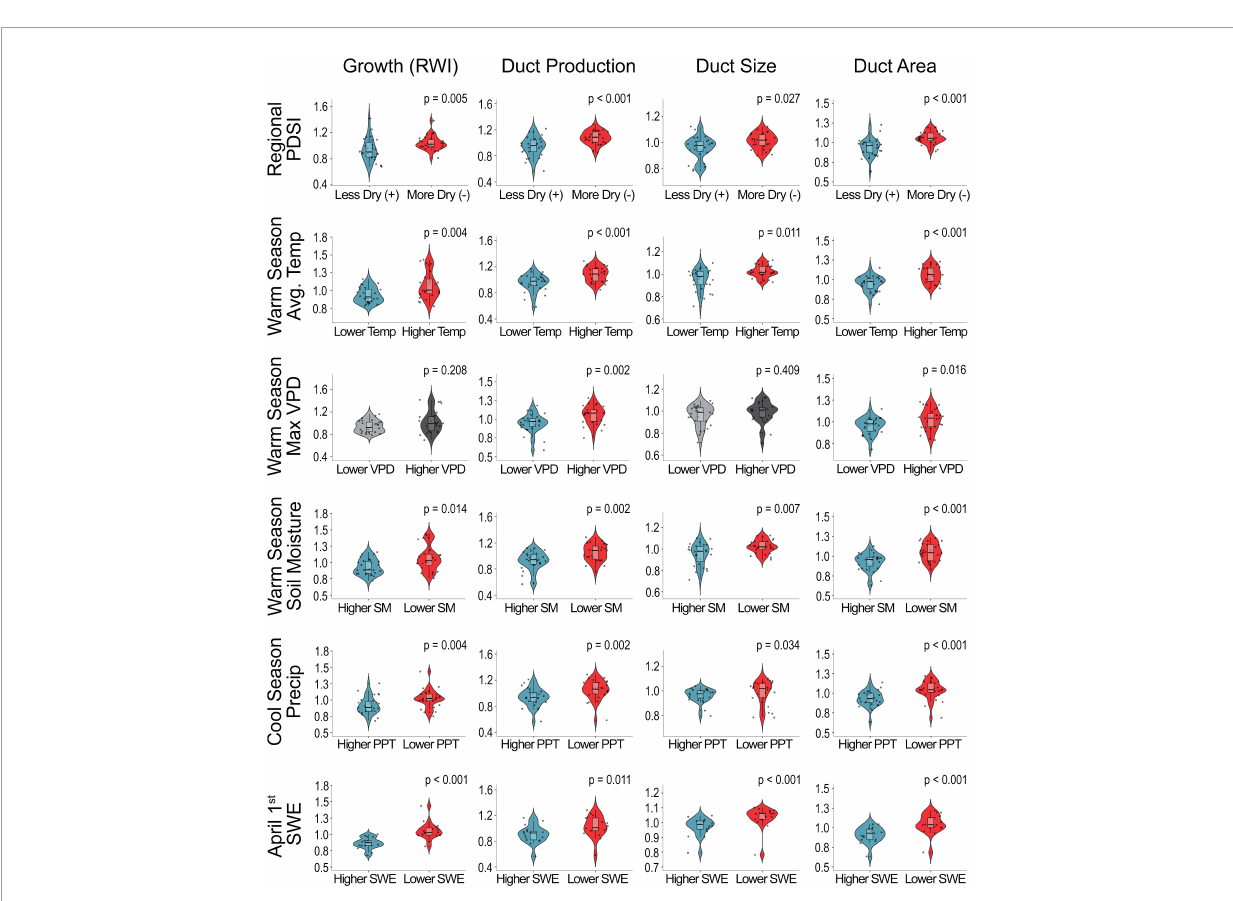
FIGURE3 Comparison of detrended whitebark pine tree growth and resin duct morphology across the upper and lower quartiles of reported climate variables from 1924 to 2015: annual average palmer drought severity index (PDSI), warm season (May-September) average temperature ( ◦ C), maximum vapor pressure deficit (VPD), soil moisture storage, cool season (October–April) precipitation (mm), and April 1st snow-water equivalence (SWE). The blue- and red-colored plots indicates significance at the p < 0.05 level. Reported p -values are from the non-parametric Wilcoxon’s Rank-Sum Test.